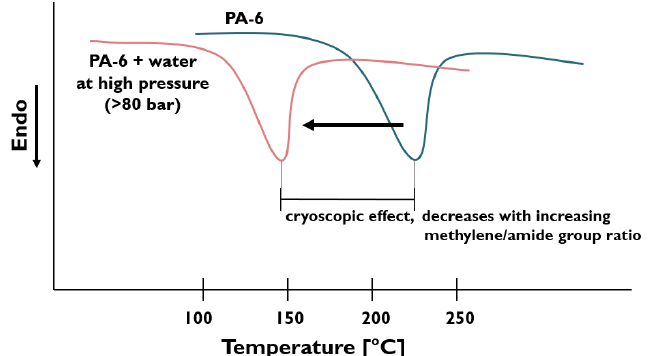
Figure 6. Differential scanning calorimetric (DSC) thermogram of polyamide 6 (PA-6) and PA-6 with water [47,48].